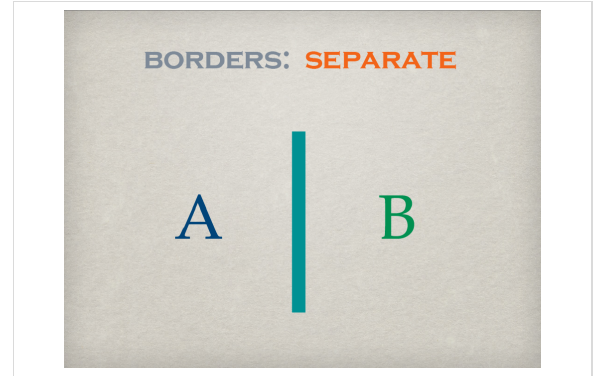
Figure 1: The bar separates A from B, one of the main functions of borders.